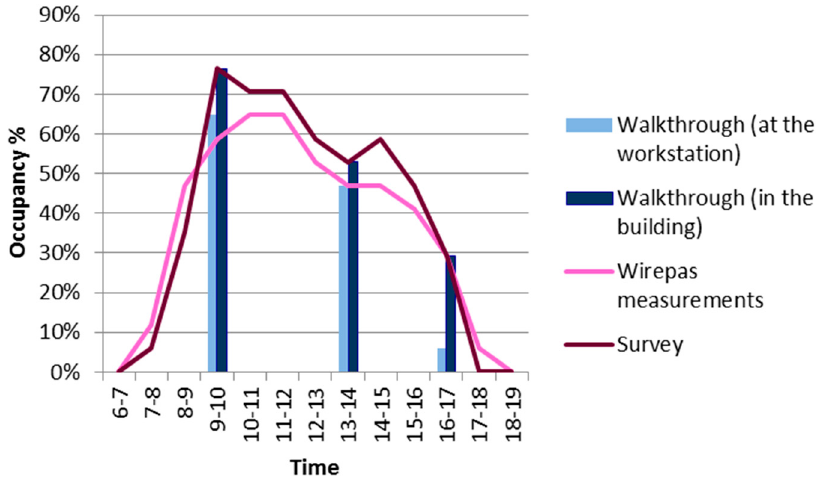
Figure 1. Occupancy levels obtained with different methods; example of one workday.